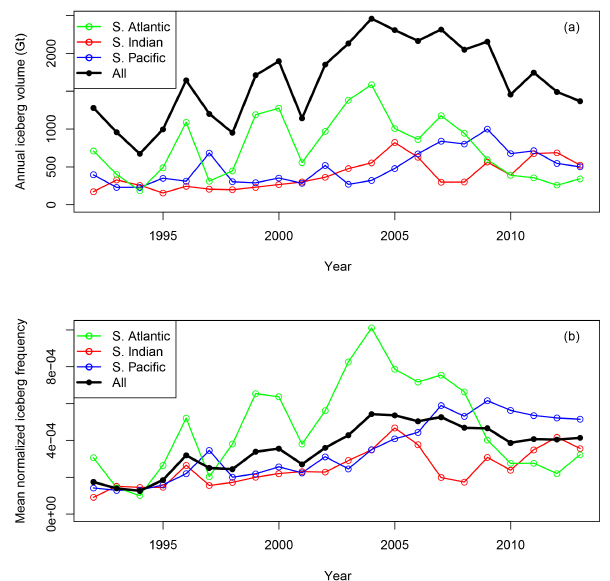
Figure 10. Temporal trend of annual total volume (a) and mean normalized frequency (b) of small icebergs by sections of the SO